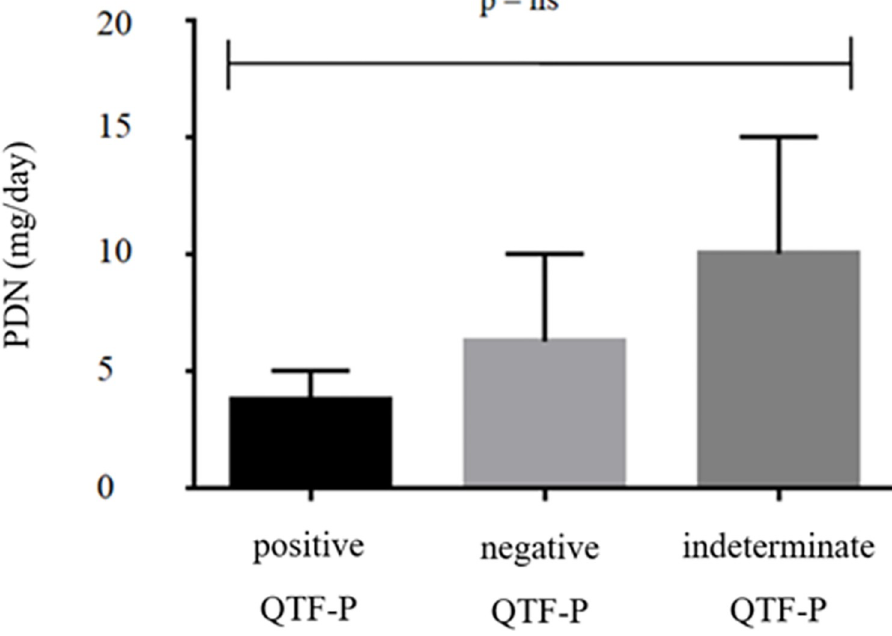
Fig 1. QFT-P results according to the dose of glucocorticoids. QFT-P: QuantiFERON-TB Gold Plus; PDN: prednisone.